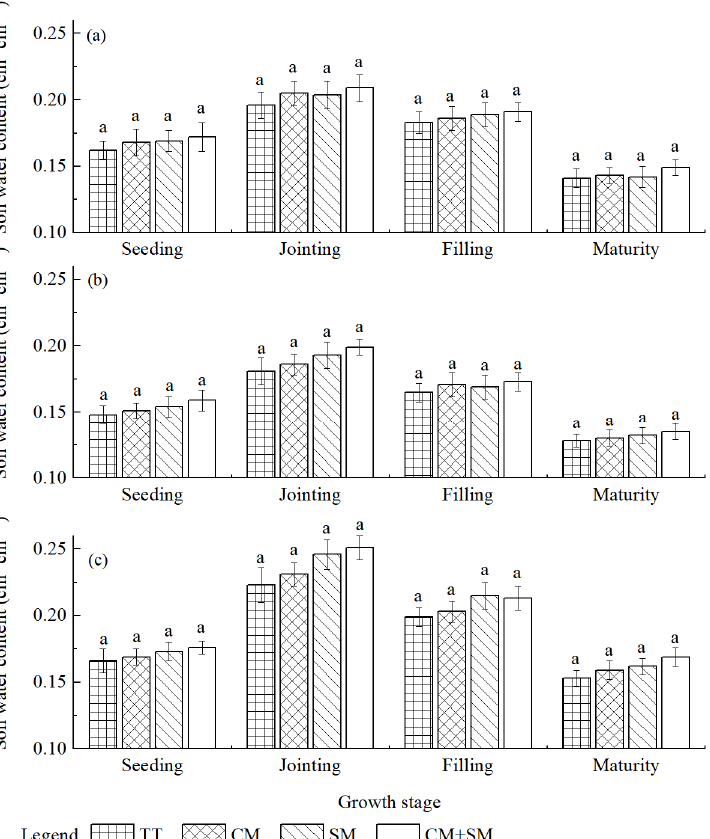
Figure 5. Mean soil volumetric water content in the upper 0.30 m of the soil profile under traditional tillage (TT), cattle manure mixing (CM), maize straw mulching (SM), and combined manure mixing and straw mulching (CM + SM) treatments at key growing stages in the 2016 ( a ), 2017 ( b ), and 2018 ( c ) seasons. Means within same key growing stage in the same year followed by the same letter are not statistically different according to least significant difference test ( p = 0.05). Table 4. Shoot biomass and root dry weight of maize at seeding stage for traditional tillage (TT), cattle manure mixing (CM), maize straw mulching (SM), and combined manure mixing and straw mulching (CM + SM) treatments during the cropping years. Means within a column in the same year followed by the same letter are not statistically different according to least significant difference test ( p =